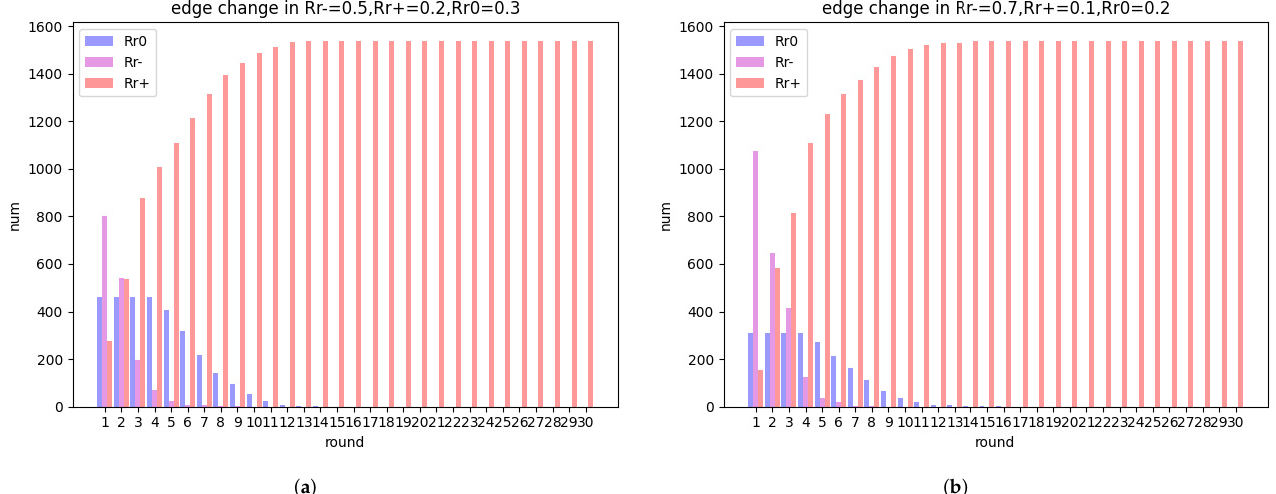
Figure 16. Effects of different initial ratios of negative edges: h s changes with time.